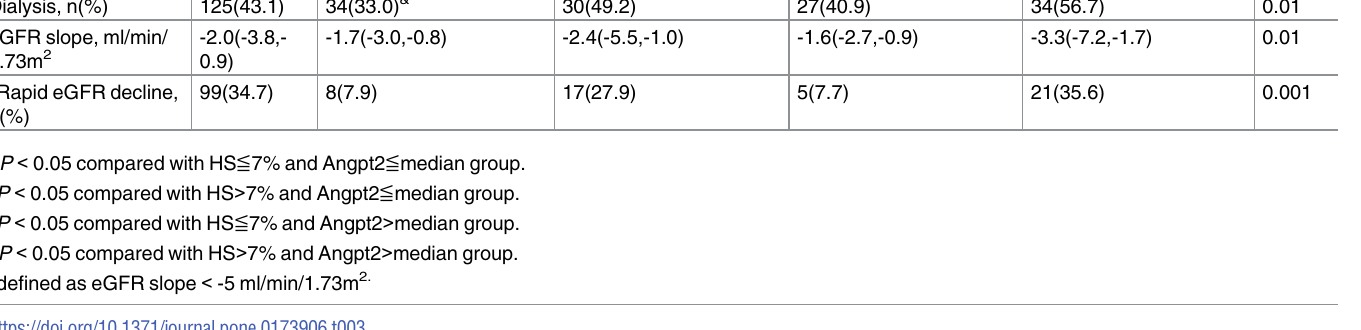
Table 3. Events of study subjects stratified by fluid status and circulating angiopoietin-2 (Angpt2) level. Entire Cohort Follow-up time, month 38.6 ±